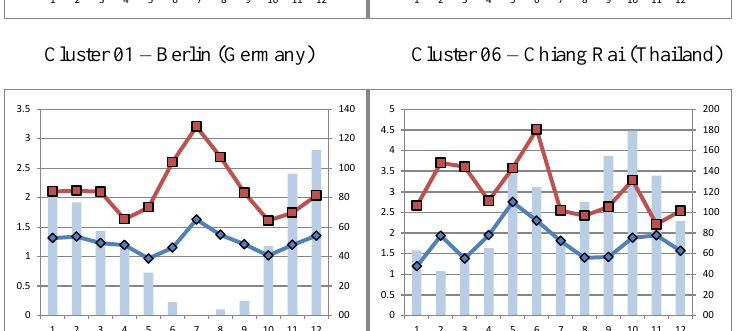
Cluster 10 – Rabat/Kenitra (Morocco) Cluster 25 – Kingston (Jamaica)